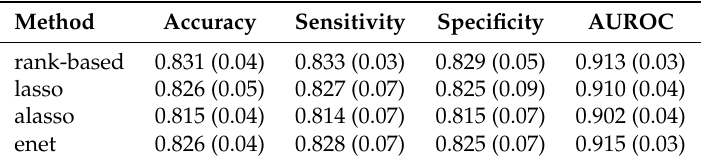
Table 3. Comparison of the performance among the four methods over 200 replications under simulation scenario 2. The values in parentheseses are the standard